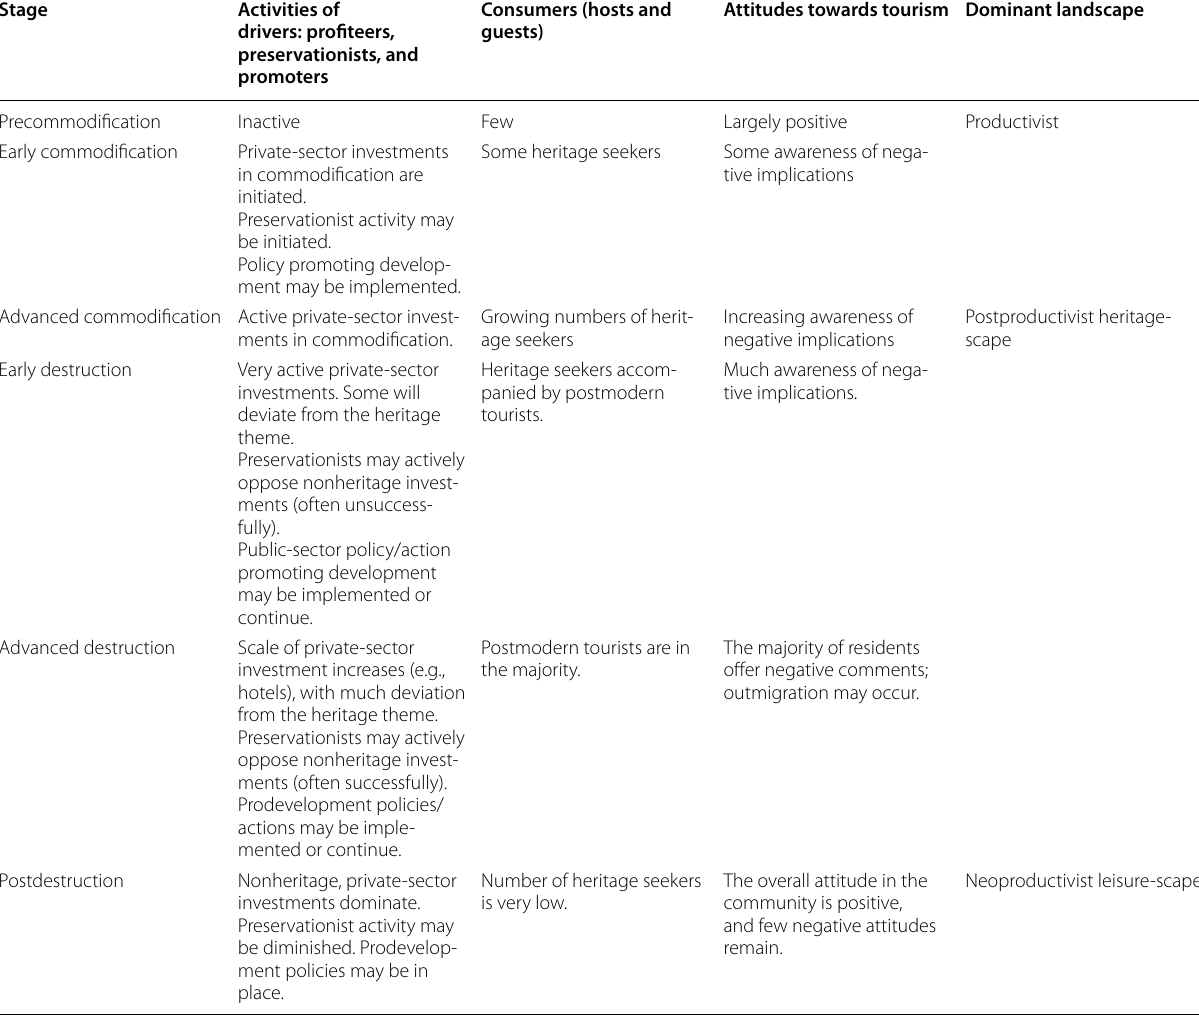
Source: Based on Mitchell’s six-stage creative destruction model (Mitchell and de Waal